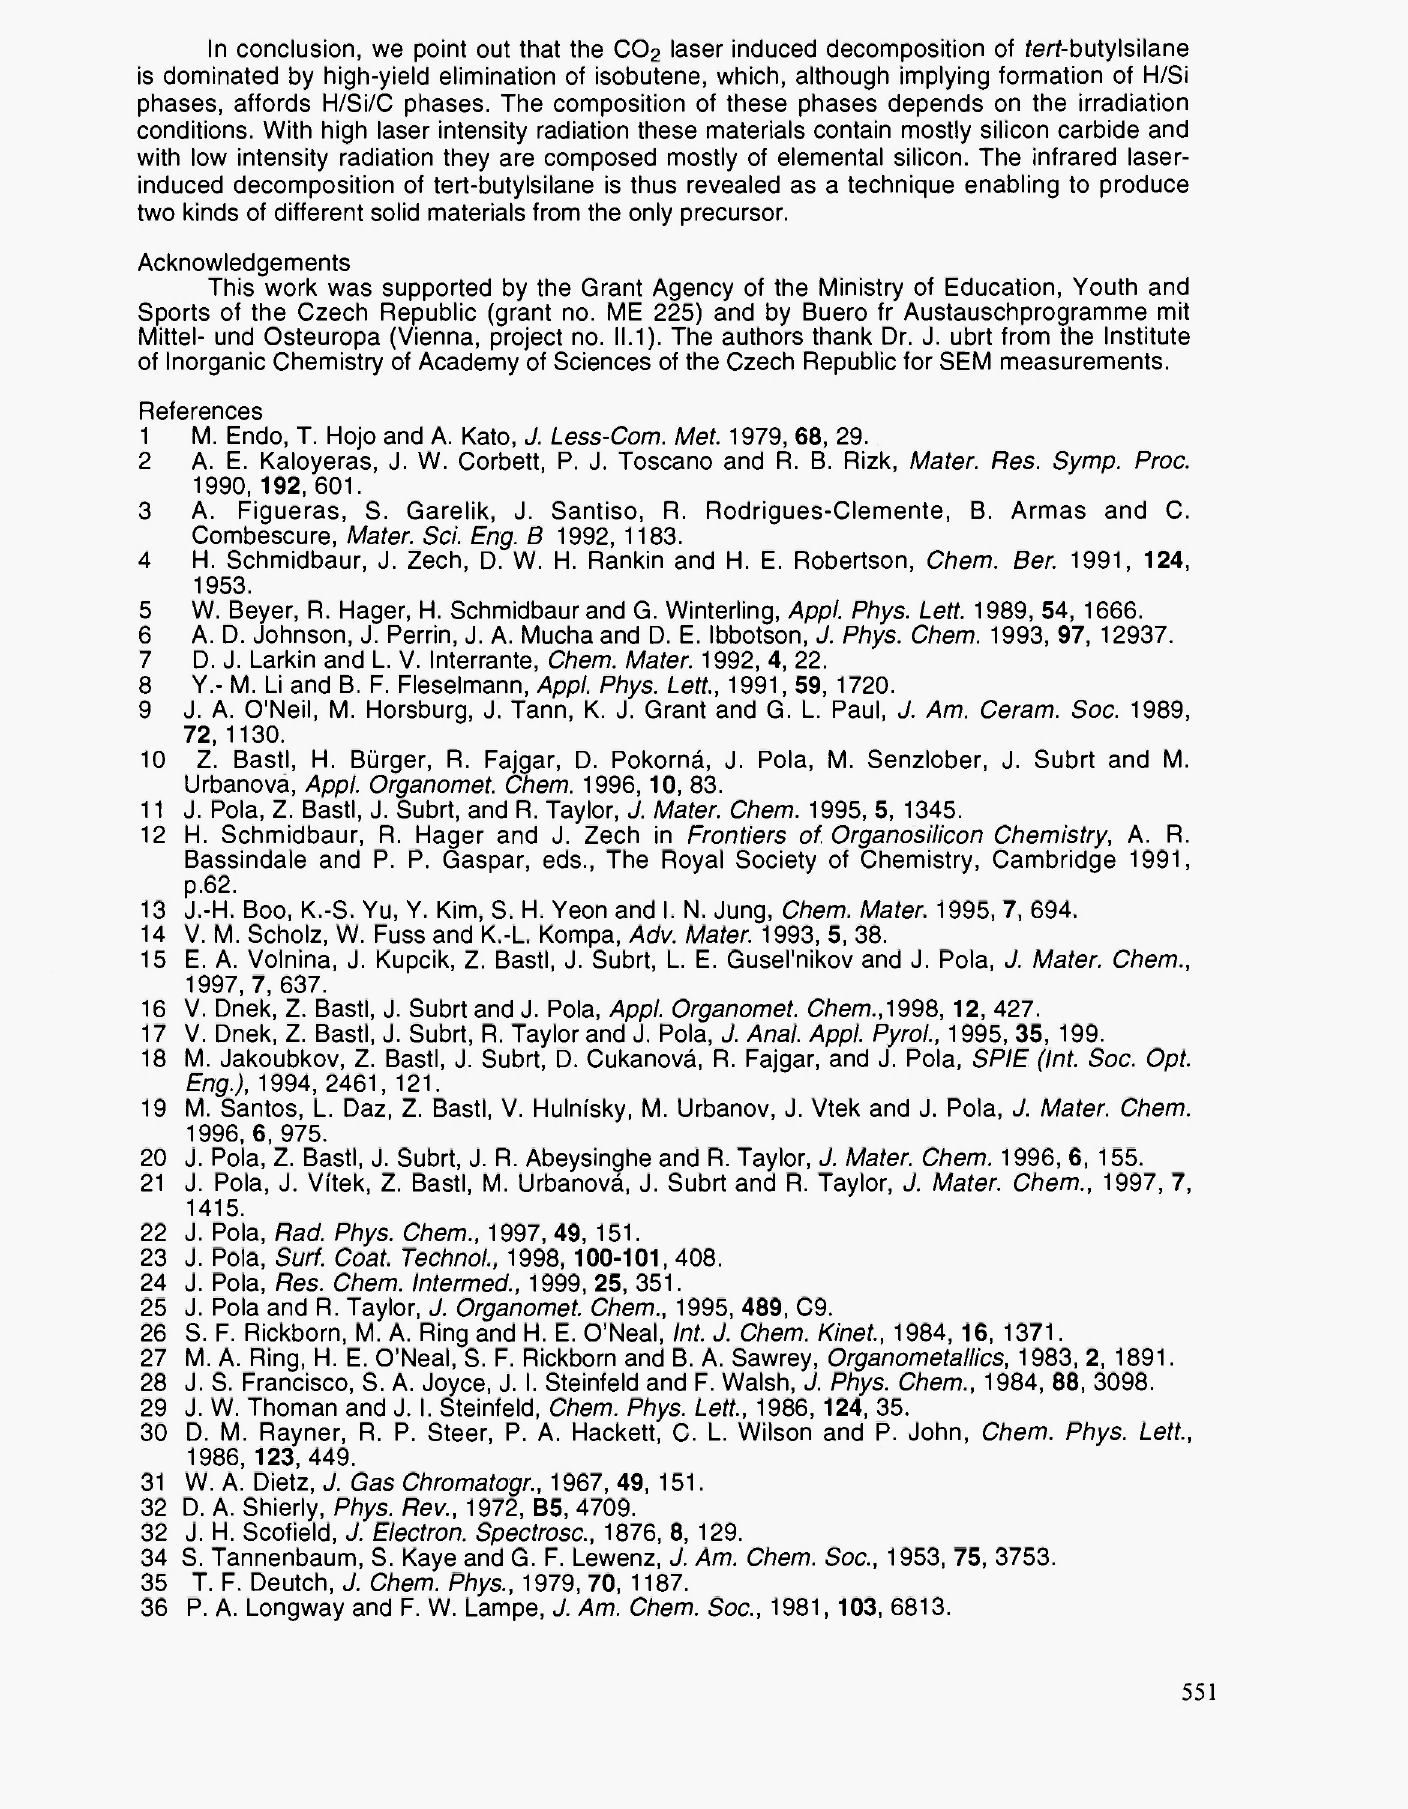
Figueras, S. Garelik, J. Santiso, R.